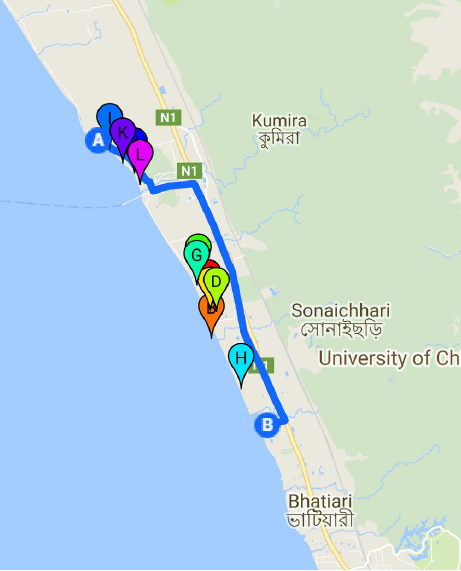
Figure 2. Yards visited during the field trips in Chittagong, Bangladesh, shown in Google map 2017. The yards A, B, C, D, E, F, G, H constitute first cluster while I, J, K, L constitute second cluster. The blue boundary signifies the total yard boundary in Bangladesh.